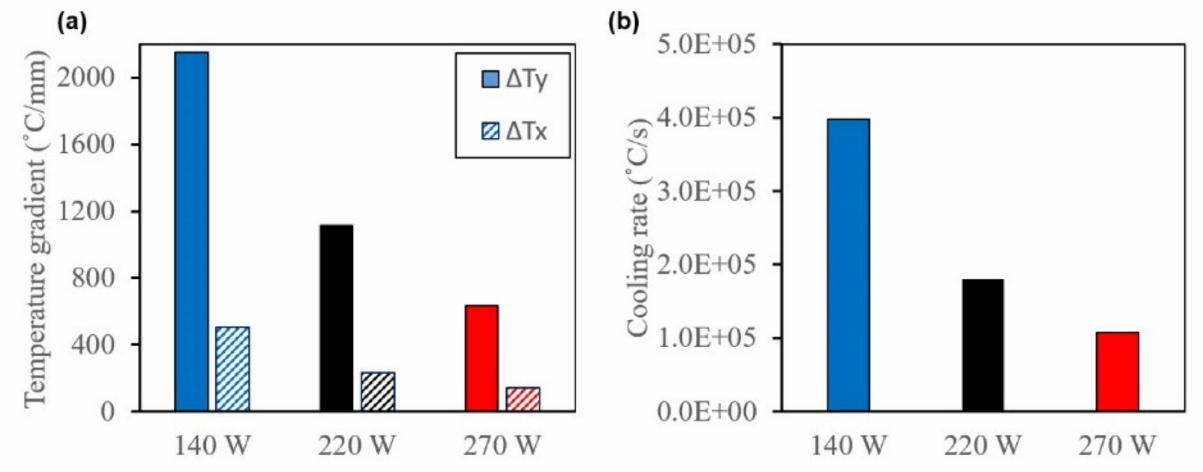
Figure 27. Effect of laser power on surface RS.